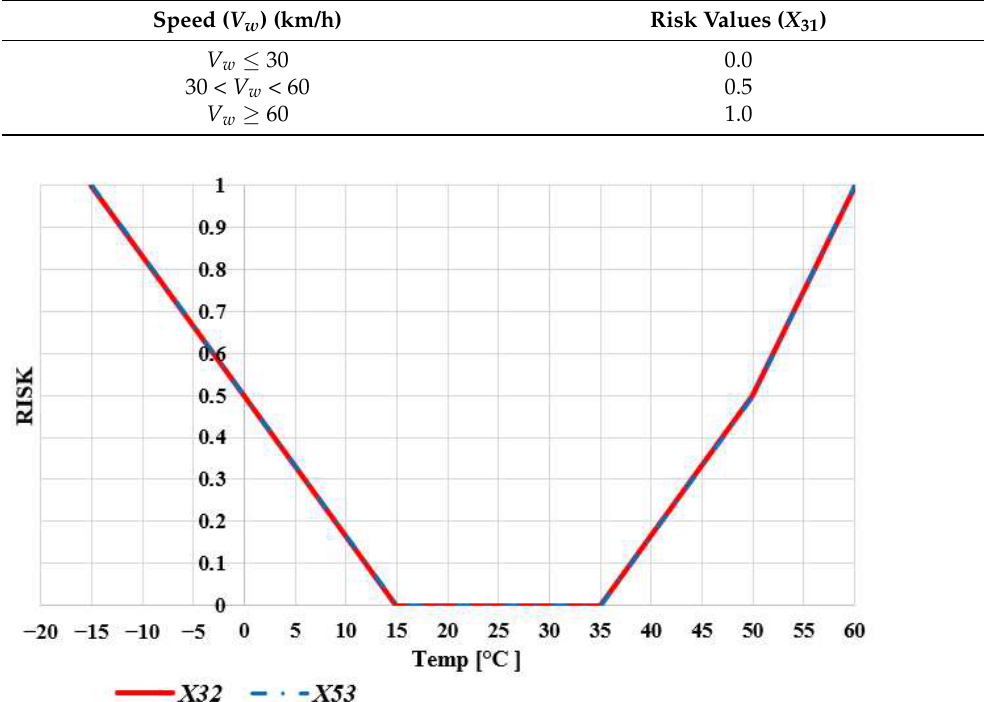
Table 1. Relation between wind force and risk values.